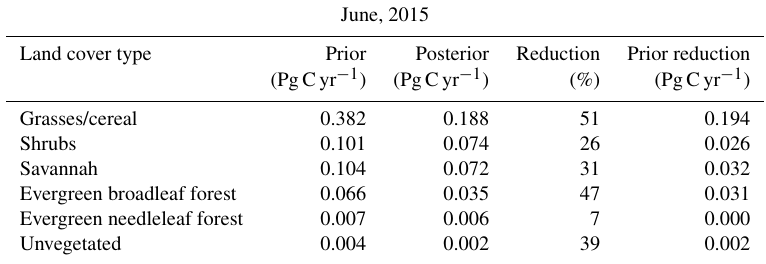
Table B2. Uncertainty reduction of total CO 2 Australian flux (in PgCyr − 1 ) classified by MODIS ecotype (June, 2015).